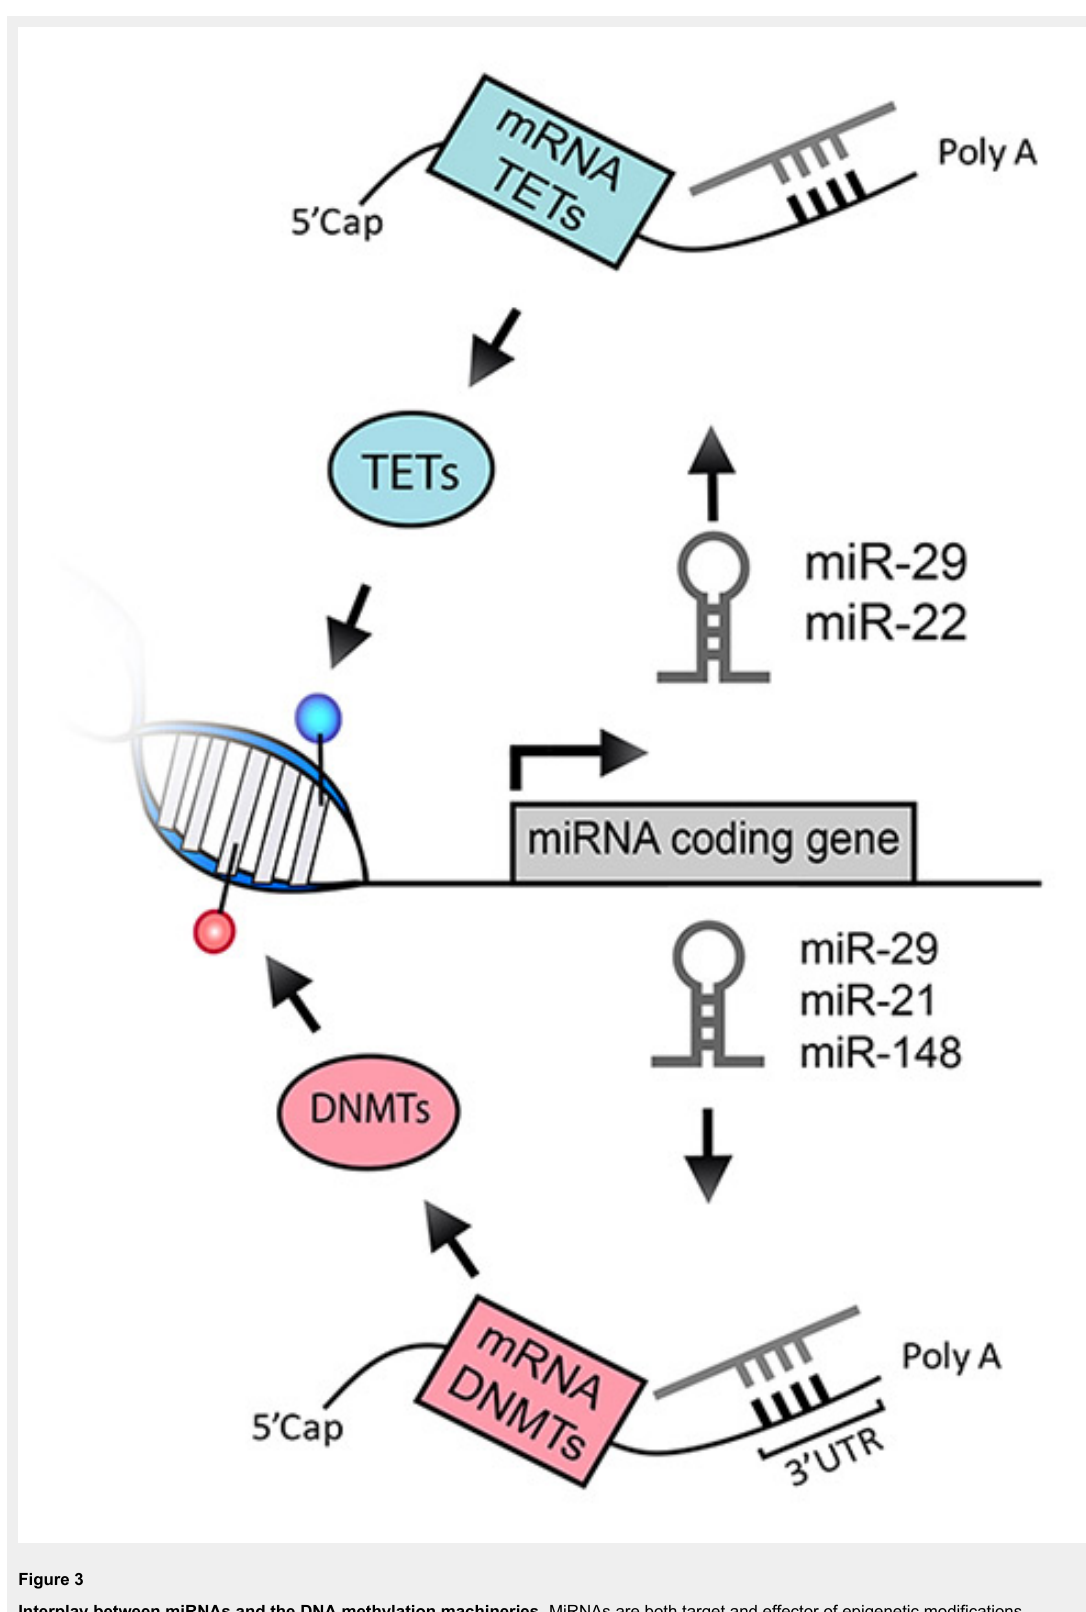
Figure 3 Interplay between miRNAs and the DNA methylation machineries. MiRNAs are both target and effector of epigenetic modifications. Expression of miRNAs can be modulated by levels of DNA methylation in the gene locus of any given miRNA. In turn, mature miRNAs bind the 3’UTR of target mRNAs leading to a reduction in protein output. DNMT and TET mRNAs can be targeted by miRNAs such as miR-29, miR-22 and others, thereby modulating the levels of DNA methylation and hydroxymethylation. DNMT = DNA methyltransferase; miRNA = micro RNA; mRNA = messanger RNA; TET = ten-eleven translocation protein; UTR = untranslated